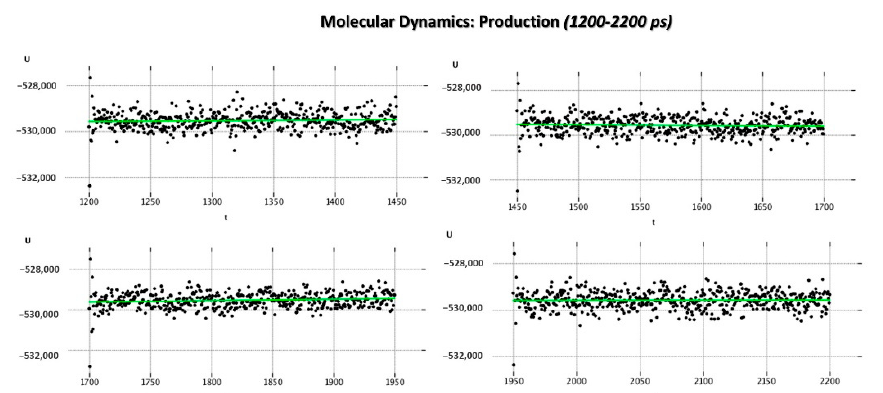
Figure 9. Potential energy (kcal/mol) and kinetic energy (kcal/mol) variation of the 5KWW complex as function of time during MD_P (1200–2200 ps) phase.